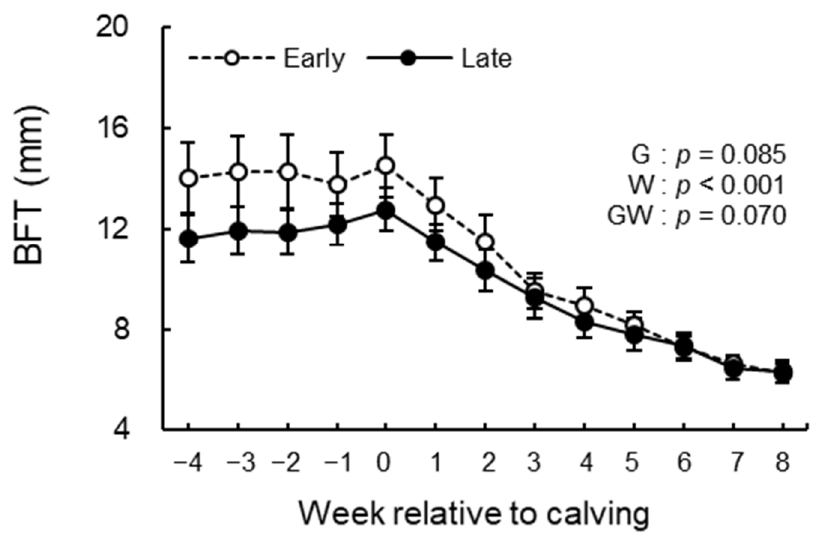
Figure 5. BFT from −4 to 8 wk relative to calving for cows classified into the early group (Early) and the late group (Late). Early = cows with endometrial inflammation converged within 4 wk, n = 17; Late = cows with endometrial inflammation converged at or after 5 wk, n = 16. The week of calving is defined as 0 wk. G = group effect; W = week effect; GW = group-by-week interaction. Data are shown as mean ± SEM.